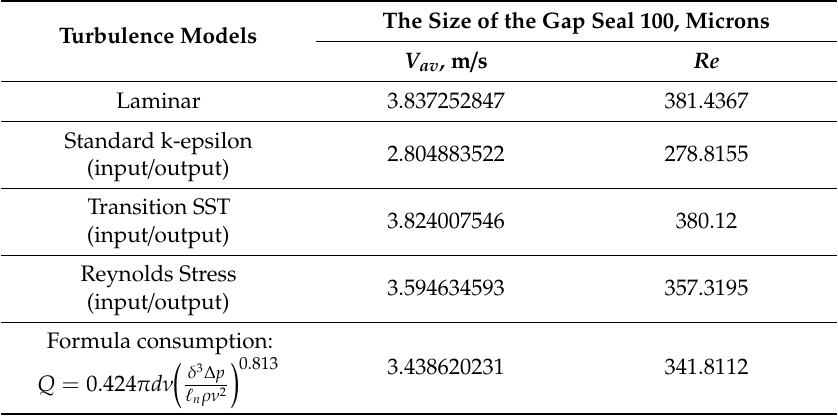
Table 7. Values of average velocities and Reynolds numbers for fluid flow in a step-type gap seals in the forward direction determined by di ff erent flow models.